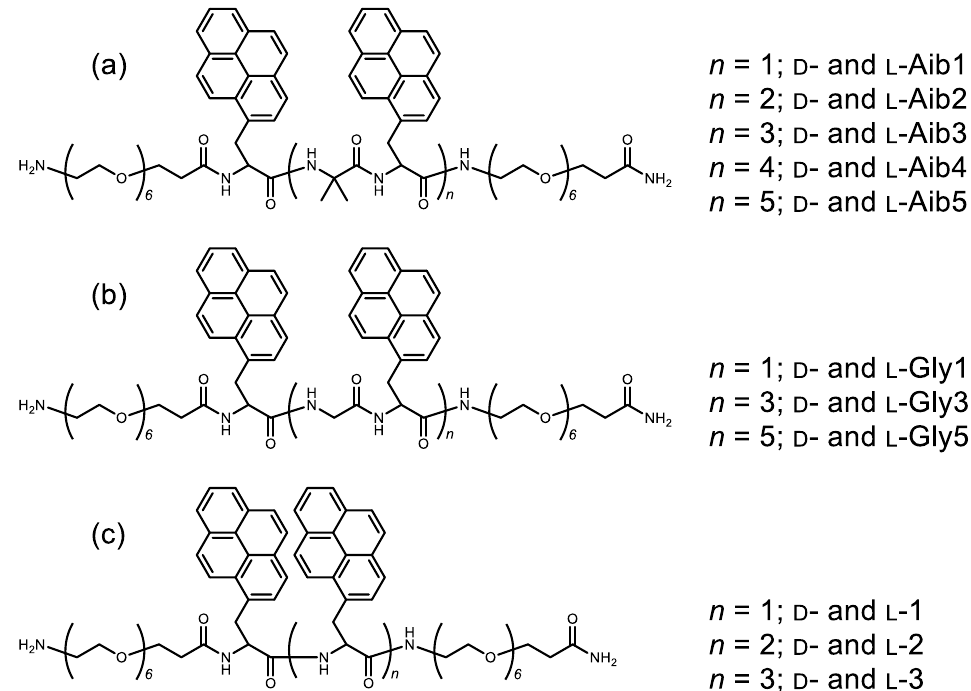
Figure 1. ( a ) Chiral 2-aminoisobutyric acid (Aib)-pyrenyl oligopeptide luminophores D -Aib1 – D -Aib5 and L -Aib1 – L -Aib5 . ( b ) Chiral Gly-pyrenyl oligopeptide luminophores D -Gly1 , D -Gly3 , D -Gly5 , and their L -isomers. ( c ) Chiral pyrenyl oligopeptide luminophores D -1 – D -3 and L -1 – L -3 .